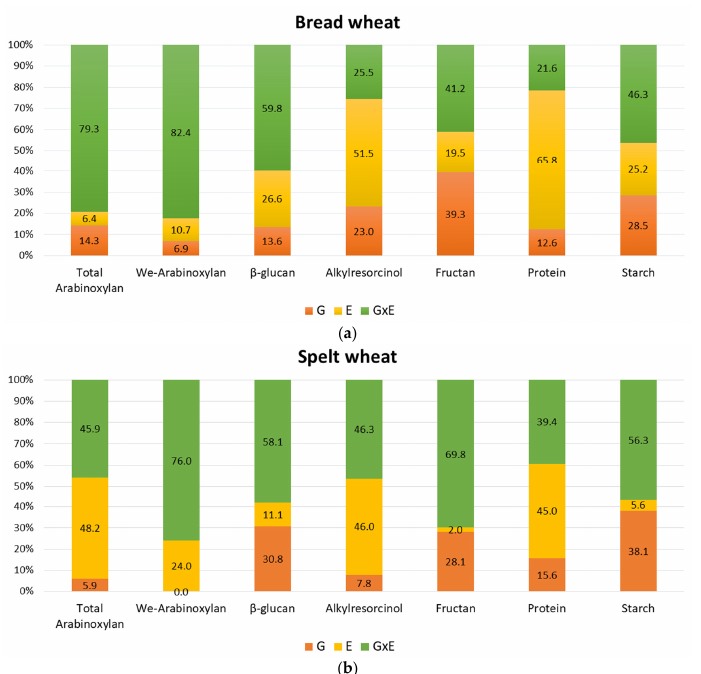
Figure 2. Column charts of the relative contribution of genotype (G), environment (E—3 farming systems) and genotype × environment interaction (G×E) to the total variance of the bioactive compound, protein and starch content of bread ( a ) and spelt ( b ) wheat.